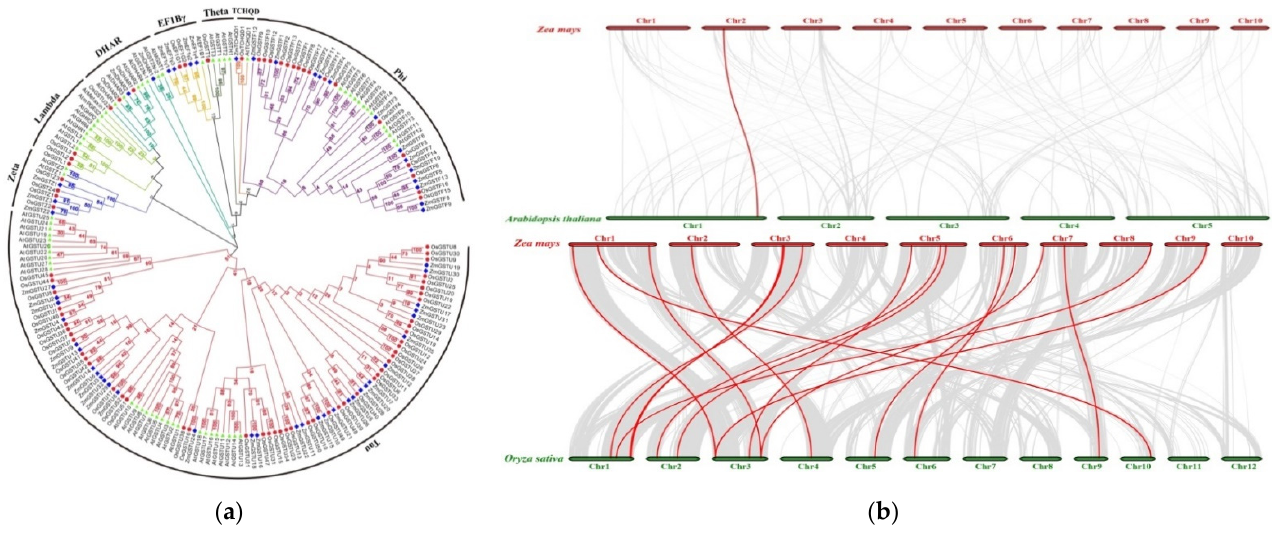
Figure 4. Phylogenetic and synteny analysis among Zea mays , Oryza sativa, and Arabidopsis thaliana . ( a ) Phylogenetic trees and classification of glutathione transferase proteins of the published GST proteins. The phylogenetic trees were constructed based on multiple sequence alignment using Clustal X followed by the maximum-likelihood method using JTT model MEGA7.0 software. Highlighted genes are represented with a diamond symbol. The blue color represents ZmGST genes. ( b ) Synteny analysis of GST genes. The gray lines in the background indicate the collinear blocks within Zea mays and the other two plant genomes. The red-colored lines highlight the syntenic GST gene pairs.